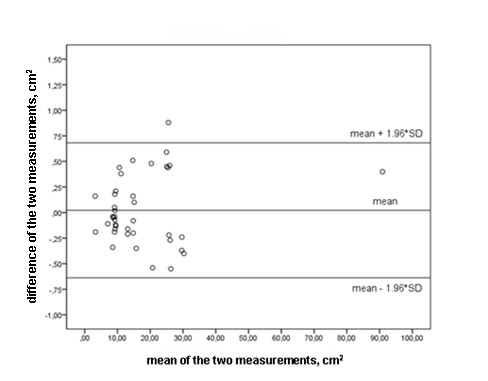
Bland-Altman plot with 95% limits of agreement for intraobserver measurement variability (measurement of the non aerated dependent lung sonographic area, cm2).